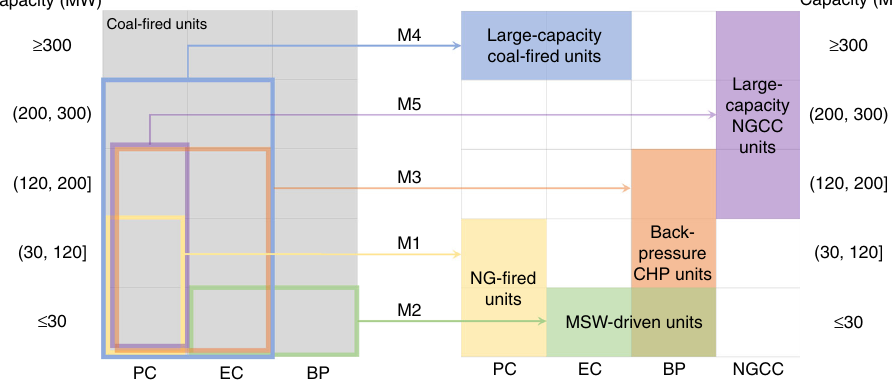
Fig. 3 Matchmaking between GHG mitigation measures and energy infrastructure units. PC, pure condensing; EC, extraction condensing; BP, back pressure; NGCC, natural gas combined cycle; CHP, combined heat and power; and MSW, municipal solid waste. M1 – M5 work on their appropriate candidates in different capacities and technologies (framed on the left), by retro fi tting or replacing them into the units shown on the